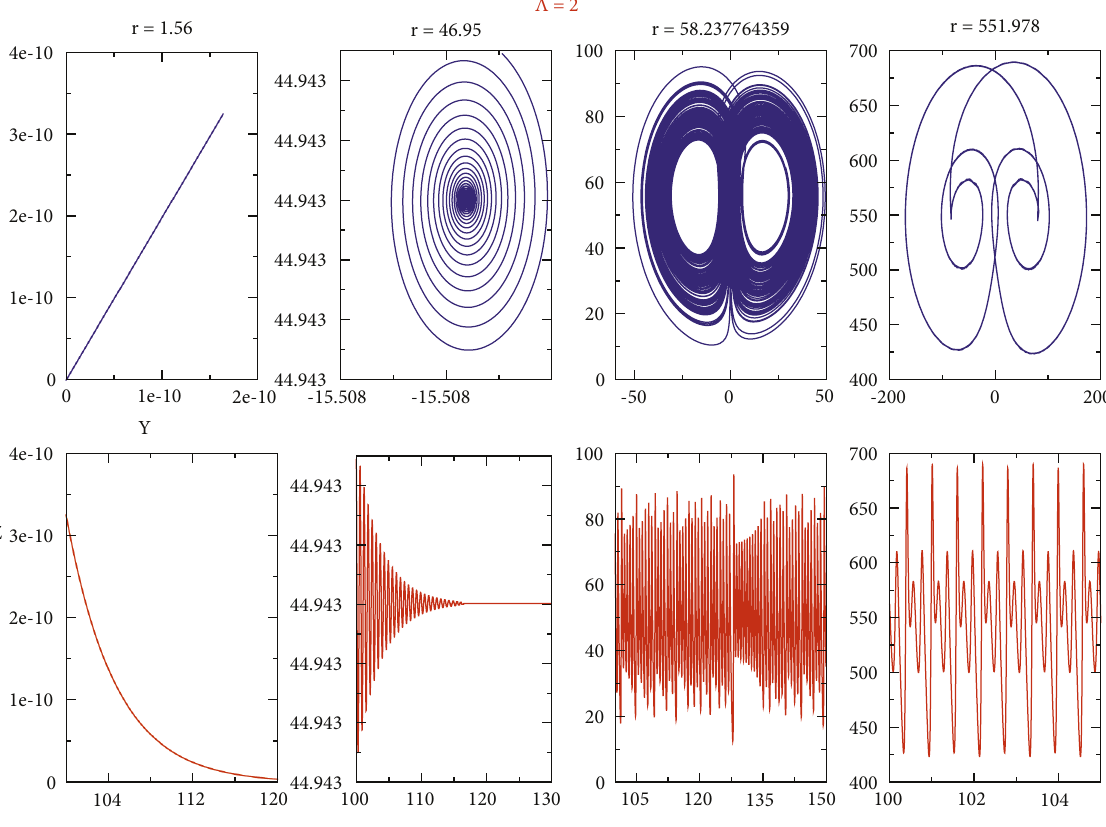
Figure 4: Phase portraits and time diagrams for different values of the reduced Rayleigh number r when Λ � 2 with the parameter values of Figure 2.